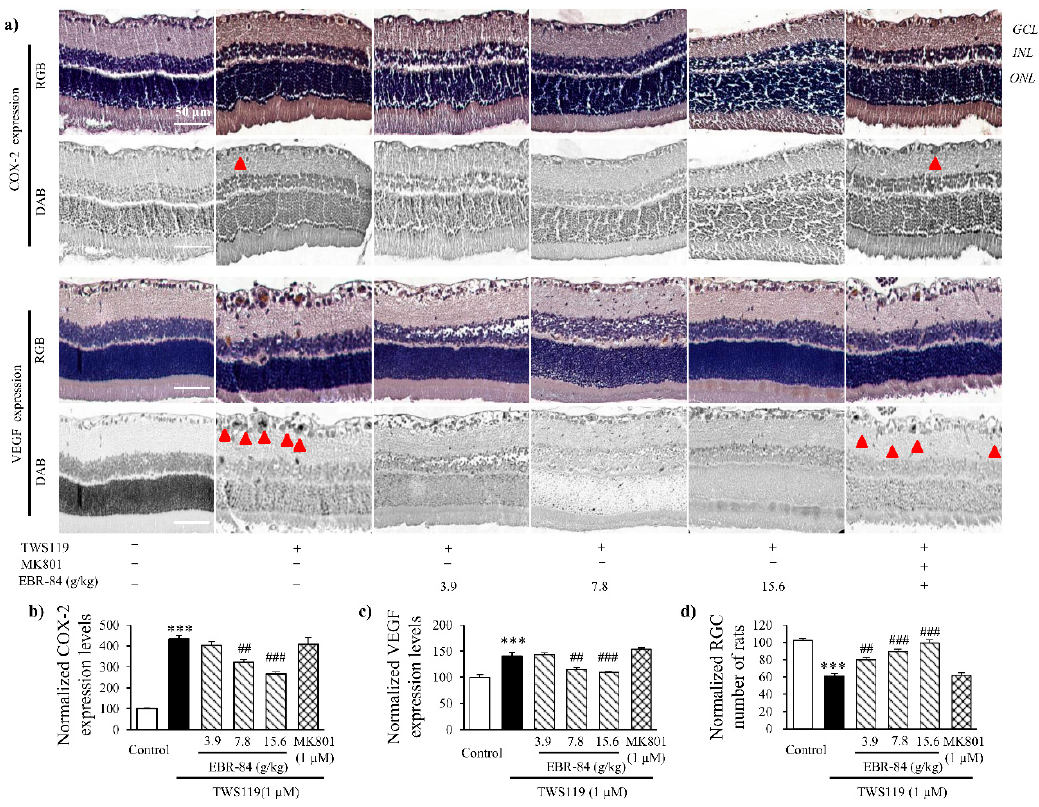
Figure 6. The effects of EBR-84 on COX-2 and VEGF expression and RGC number in the retinas of TWS119-treated rats. ( a ) Representative multispectral images for immunohistochemical staining of COX-2 and VEGF in the rat retinas. The red arrows denote the places that express COX-2 and VEGF in GCL. ( b ) Quantification of normalized COX-2 expression level using multispectral image analysis in the rat retinas ( n = 5). ( c ) Quantification of normalized VEGF expression level using multispectral image analysis in the rat retinas ( n = 5). ( d ) The normalized RGC numbersin rats ( n = 5). *** p < 0.001 vs. the control group; ## p < 0.01 and ### p < 0.001 vs. the TWS119 group. The magnification of all figures is × 200. Scale bar is 50 µ m for all images.